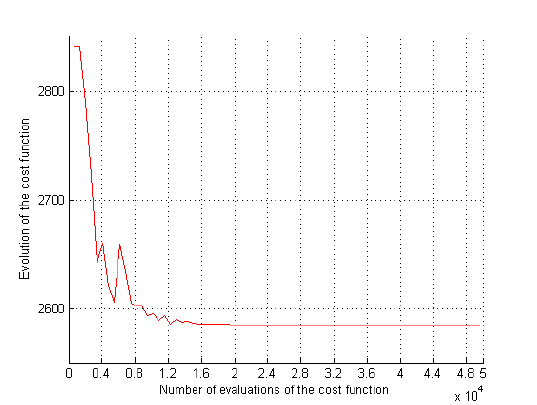
Fig. 4. 17-bar truss, evolution of the cost